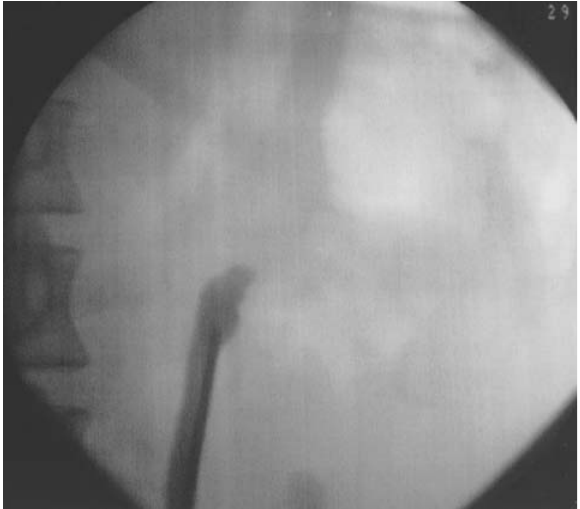
Figure 2 – Ureteroscopy is performed until the obstruction site and retrograde ureterography is performed through the ureteroscope showing total